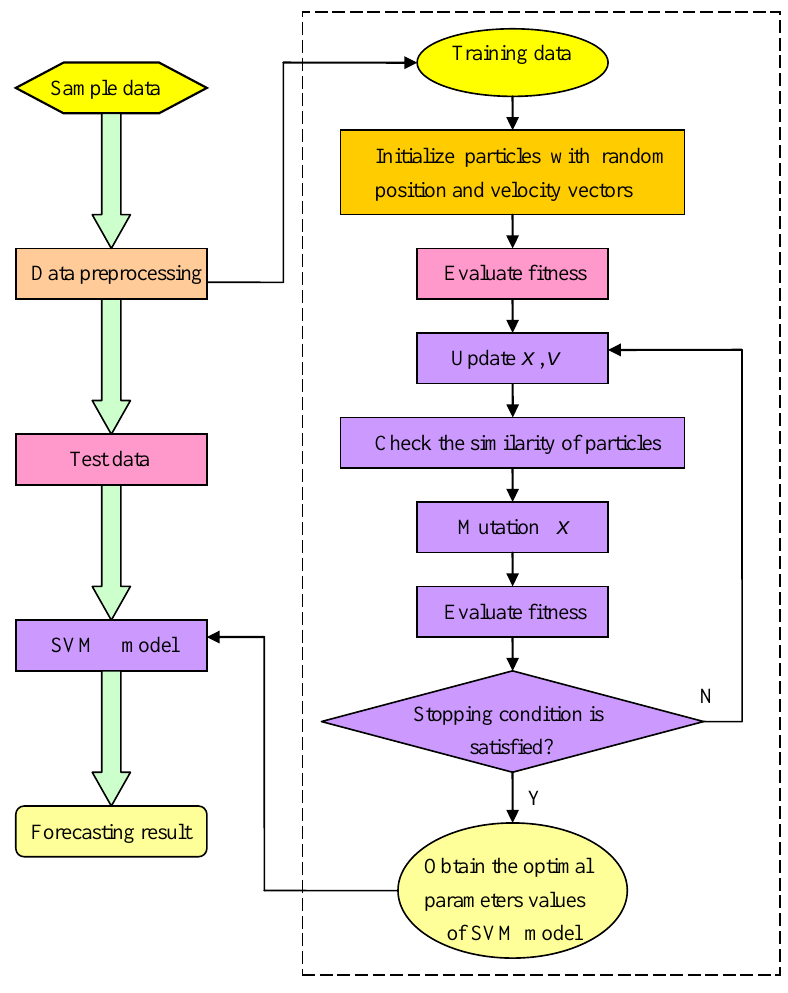
Figure 4. Diagram of the support vector machine and improved particle swarm optimization (SVM-IPSO) forecasting